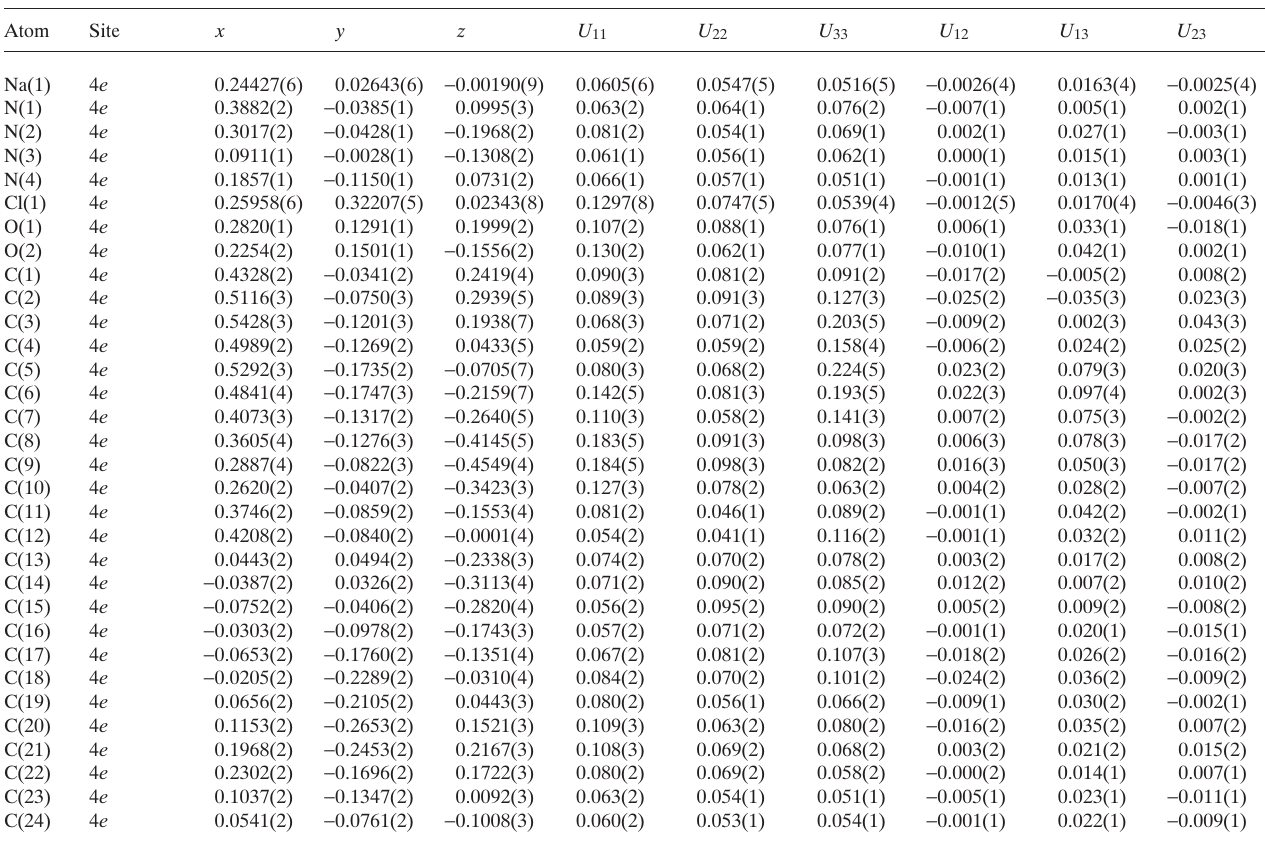
Table 3. Atomic coordinates and displacement parameters (in Å 2 ) .